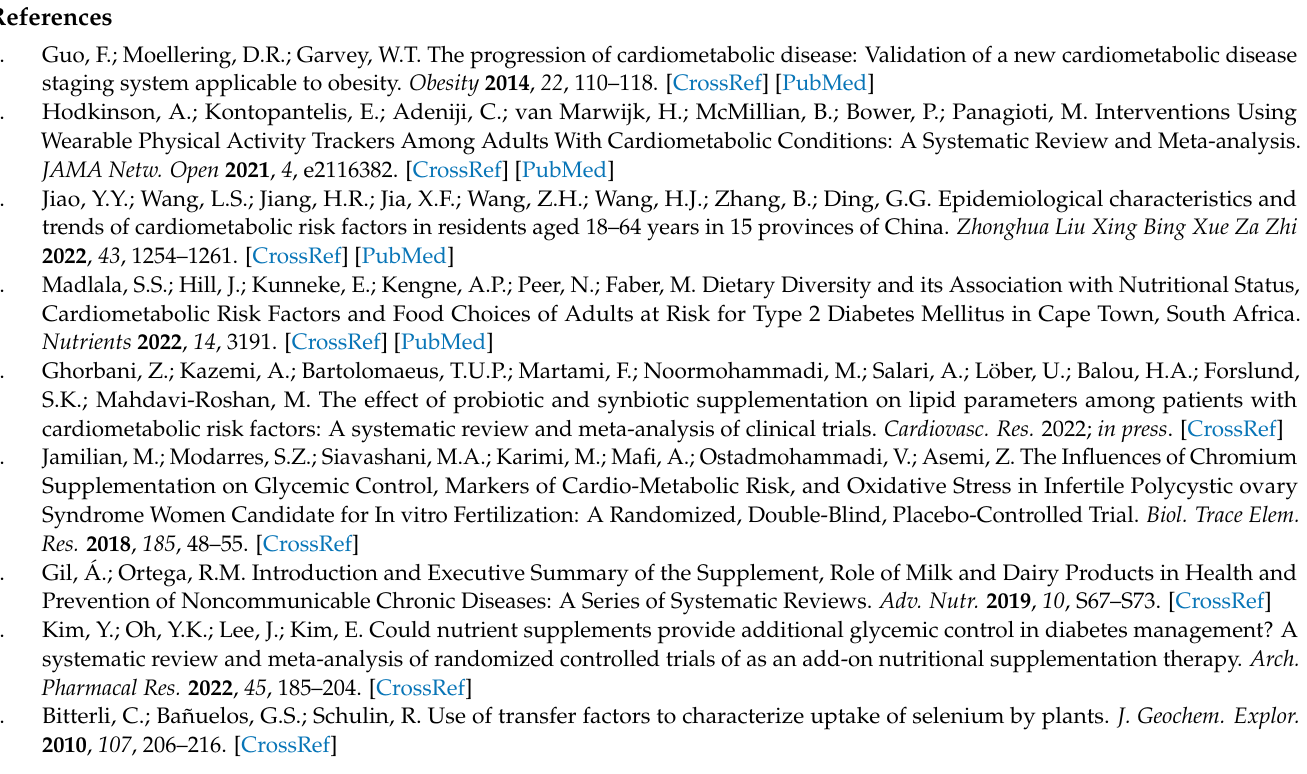
database; Figure S1. Sensitivity analysis of insulin levels; Figure S2. Sensitivity analysis of HOMA-IR; Figure S3. Forest plot of FPG; Figure S4. Sensitivity analysis of FPG; Figure S5. Forest plot of HDL-C; Figure S6. Sensitivity analysis of HDL-C; Figure S7. Forest plot of HDL-C after excluding Ghazi 2021